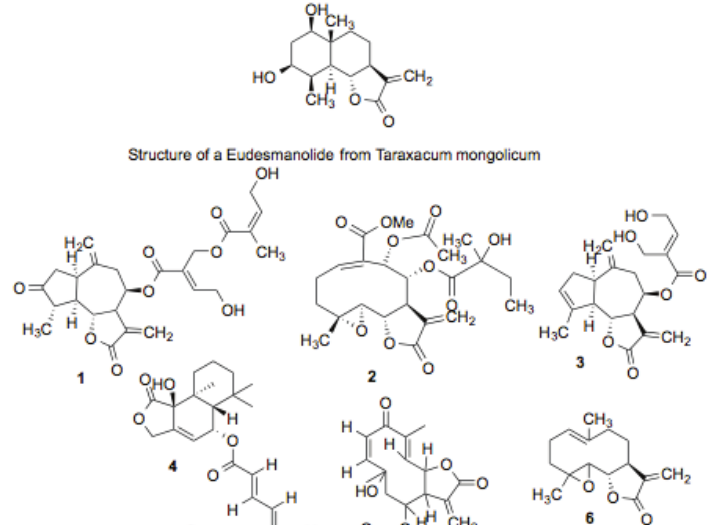
Figure 2. Sesquiterpine lactones, tetracyclic sestorpenoids and